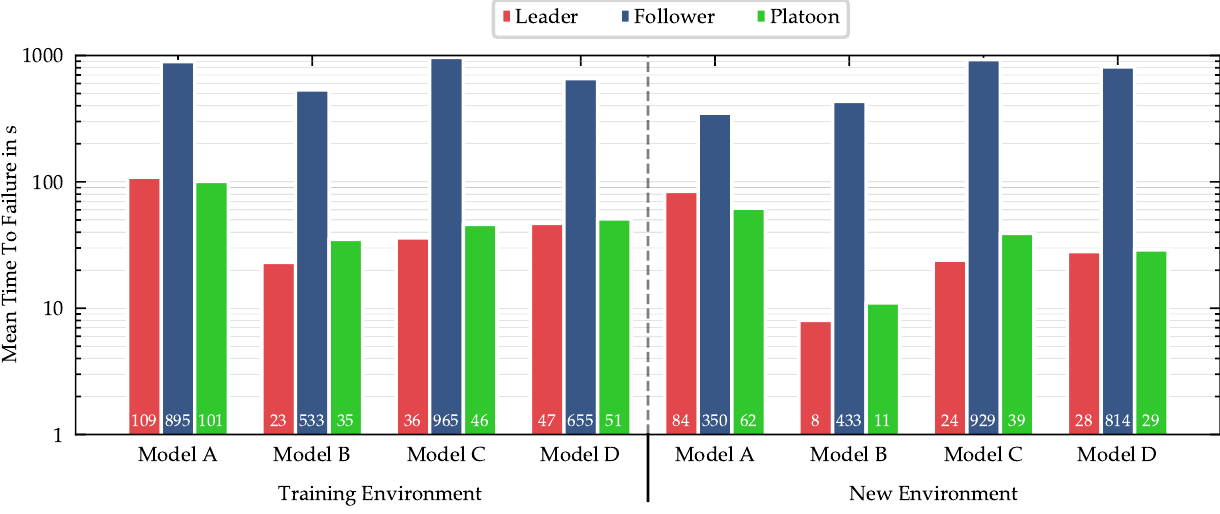
Figure 8. Mean time to failure (MTTF) in seconds for four different models in two environments. The results for the platoon refer to a two-vehicle platoon consisting of one leading and one following vehicle ( A : multi-task network baseline, B : multi- task network with LSTM extension, C : multi-task network with pre-trained feature extractor, D : single-task